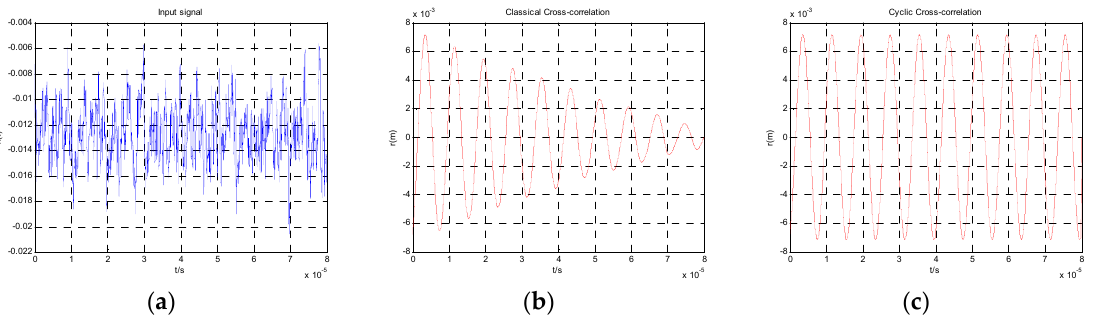
Figure 2. Results of the two kinds of correlation operations. ( a ) Input signal; ( b ) result of classical correlation operation; ( c ) result of the cyclic cross-correlation operation.